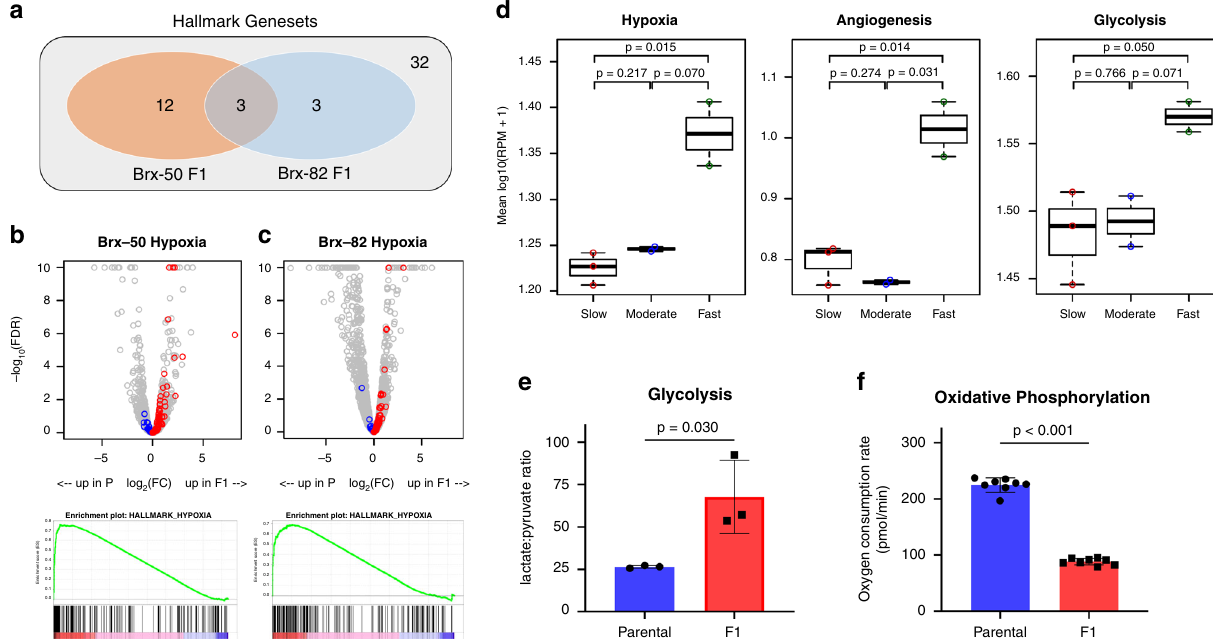
Fig. 3 Brain-pro fi cient CTC lines demonstrate increased hypoxic signaling. a Venn diagram of Gene Set Enrichment Analysis (GSEA) of transcripts upregulated in Brx-50 or Brx-82 F1 versus parental cells. Enriched genesets within the Hallmarks of Cancer gene sets from the Broad Molecular Signatures Database are highlighted. b, c Top panels: Volcano plots for expression of genes in Brx-50 ( b ) or Brx-82 ( c ) parental and F1 cells, as determined by RNA- seq. Genes in the Hallmarks of Cancer Hypoxia geneset from the Broad Molecular Signatures Database are colored, with blue indicating higher expression in parental cells and red indicating higher expression in F1 cells. Gray markers represent all genes not in the Hypoxia geneset. Genes with -log 10 (FDR) > 10 are displayed as − log 10 (FDR) = 10. Bottom panels: Enrichment plots of the Hallmarks of Cancer Hypoxia geneset for genes enriched in Brx-50 ( b ) or Brx- 82 ( c ) F1 versus parental cells. Positive enrichment scores in enrichment plots indicate more enrichment of the geneset in F1 cells. d Mean expression of genes in the Hallmark of Cancer Hypoxia, angiogenesis, and glycolysis genesets in the seven parental breast cancer CTC lines, as determined by RNA-seq (Slow: Brx-7, Brx-68, Brx-142; Moderate: Brx-50, Brx-82; Fast: Brx-29, Brx-42). Boxplots display median, 25 th percentile, and 75 th percentile, with whiskers representing minimum and maximum. P values calculated by two-tailed unpaired t -test. e Lactate-to-pyruvate ratio in Brx-82 parental and F1 cells, as determined by metabolomic studies for relative levels of polar metabolites ( n = 3). P value calculated by two-tailed unpaired t -test. f Oxygen consumption rate of Brx-82 parental and F1 cells, as determined by live-cell Seahorse assays ( n = 8). P value (1.19 × 10 − 13 ) calculated by two-tailed unpaired t -test. Data represent mean ± SD. Source data are provided as a Source Data fi